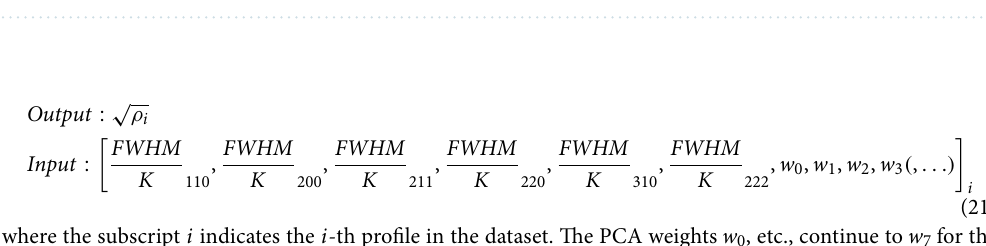
of GPR models can be found in 68,69 .